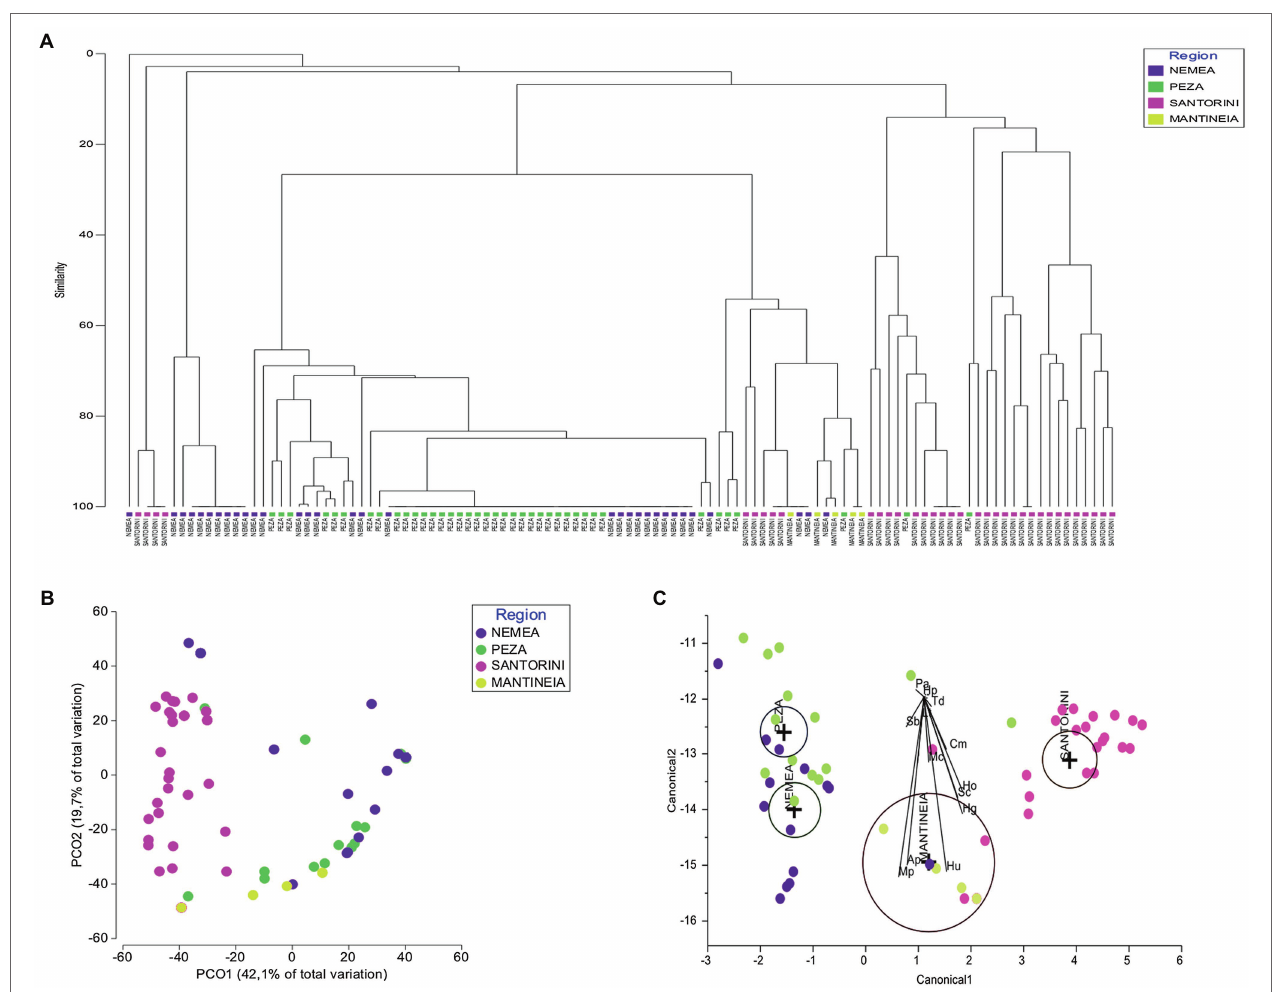
FIGURE 3 | Vineyard-associated yeast communities of Mantineia, Nemea, Peza, and Santorini viticultural regions. (A) Plot Bray–Curtis similarity dendrogram comparing yeast communities of the four regions (Cophenetic correlation: 0.93), (B) Principal coordinate analysis (PCoA) based on Bray–Curtis distances depicting resemblance of samples in a two-dimensional space, and (C) Canonical discriminant analysis plot comparing grape samples of different regions against yeast species abundances. The diameter of the circle represents a 95% of confidence interval for the mean. Significantly different groups have non- intersecting circles. Ap, Aureobasidium pullulans ; Cd, Candida diversa; Cg, C. glabrata ; Cm, C. membranifaciens ; Ct, C. tropicalis ; Cd, Cryptococcus diffluens ; Hu, Hanseniaspora uvarum ; Hg, H. guilliermondii ; Ho, H. opuntiae ; Hp, Hyphopichia pseudoburtonii ; Lt, Lachancea thermotolerans ; Mc, Meyerozyma caribbica ; Mp, Metschnikowia pulcherrima ; Pl, Papiliotrema laurentii ; Pa, Pichia anomala ; Sc, Saccharomyces cerevisiae ; Sb, Starmerella bacillaris ; and Td, Torulaspora delbrueckii